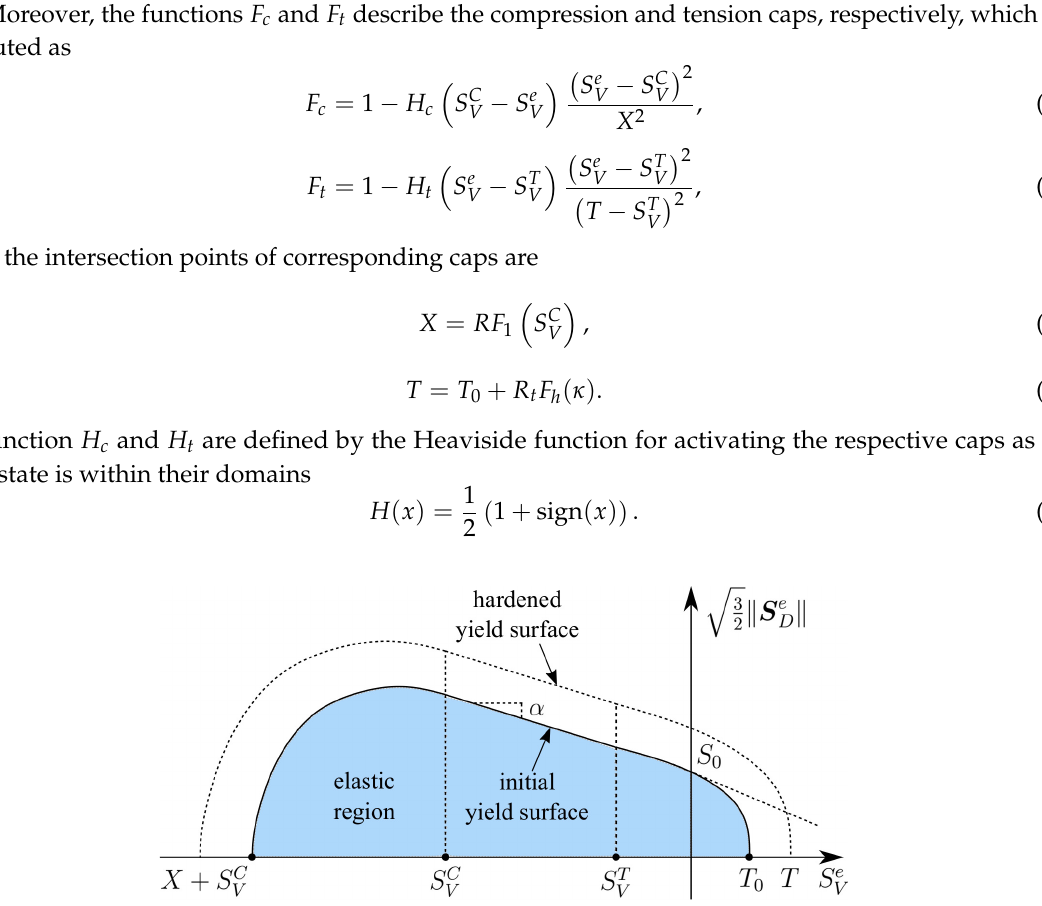
Figure 1. Smooth three-surface yield function as in [24] extended to finite